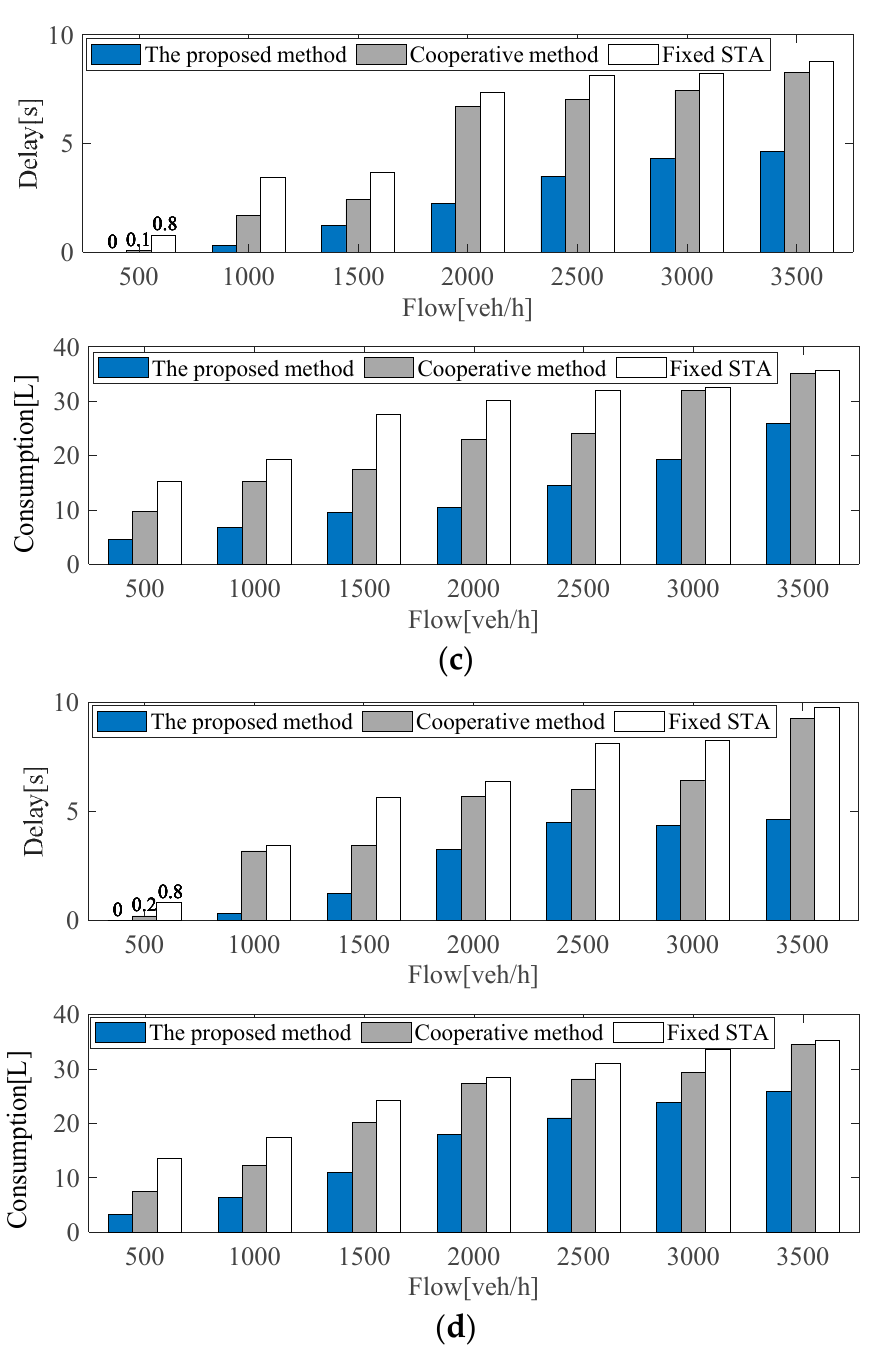
Figure 8. Comparison results of three methods at intersection subregions under different flows: ( a ) test results in the intersection subregion N5; ( b ) test results in the intersection subregion N6; ( c ) test results in the intersection subregion N7; ( d ) test results in the intersection subregion N8.